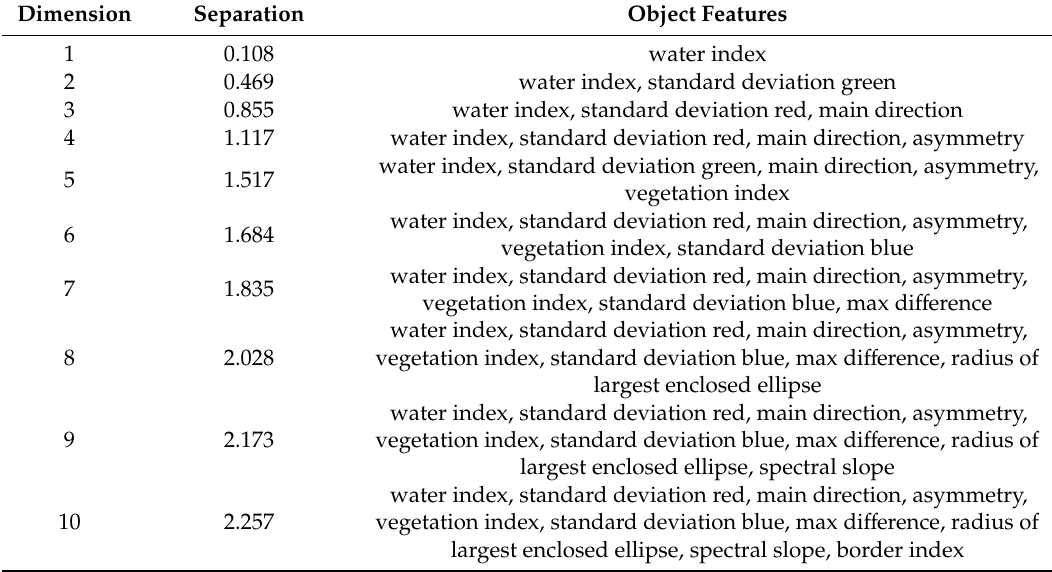
Table 1. Object features that allow for the most separation in classes at each dimension with the corresponding separation value. Dimension refers to the number of object features contributing to the separation analysis. The higher the separation value, the greater the differentiation between the classes as represented by the randomly selected samples.